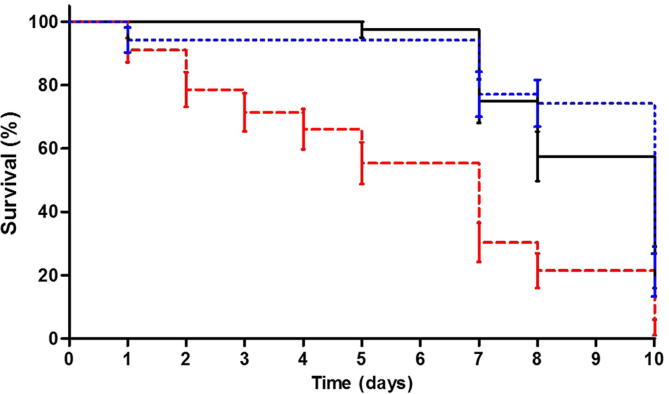
Kaplan-Meier survival curves for Ctenocephalides felis adults after no treatment (n = 40) (solid line), soaking (n = 35) (small dashed line) or microinjection (n = 56) (large dashed line) of saline. Surviving fleas were counted at intervals for 10 days post-treatment. Error bars show S.E.M.